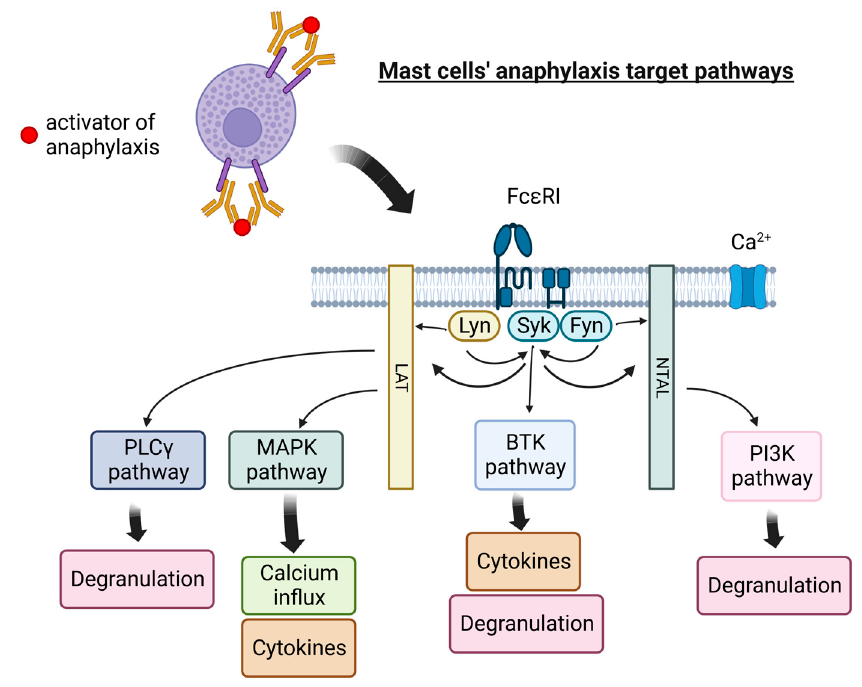
Figure 3. Mast cells’ pathways targeted in anaphylaxis therapy. PLC γ —Phosphoinositide-specific phospholipase C, MAPK—mitogen-activated protein kinases, BTK—Bruton’s tyrosine kinase, LAT—linker for activation of T cell, NTAL—non-T cell activation linker, PI3K—phosphoinositide 3-kinase, Lyn—Lyn kinase (Src family), Syk—Syk tyrosine kinase, Fyn—Fyn tyrosine kinase, Fc ε RI—a high-affinity IgE receptor. Figure created with BioRender.com.